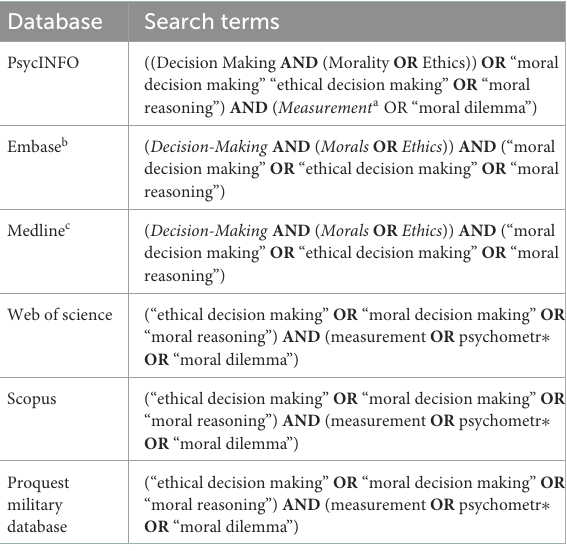
TABLE 1 Summary of search terms from six